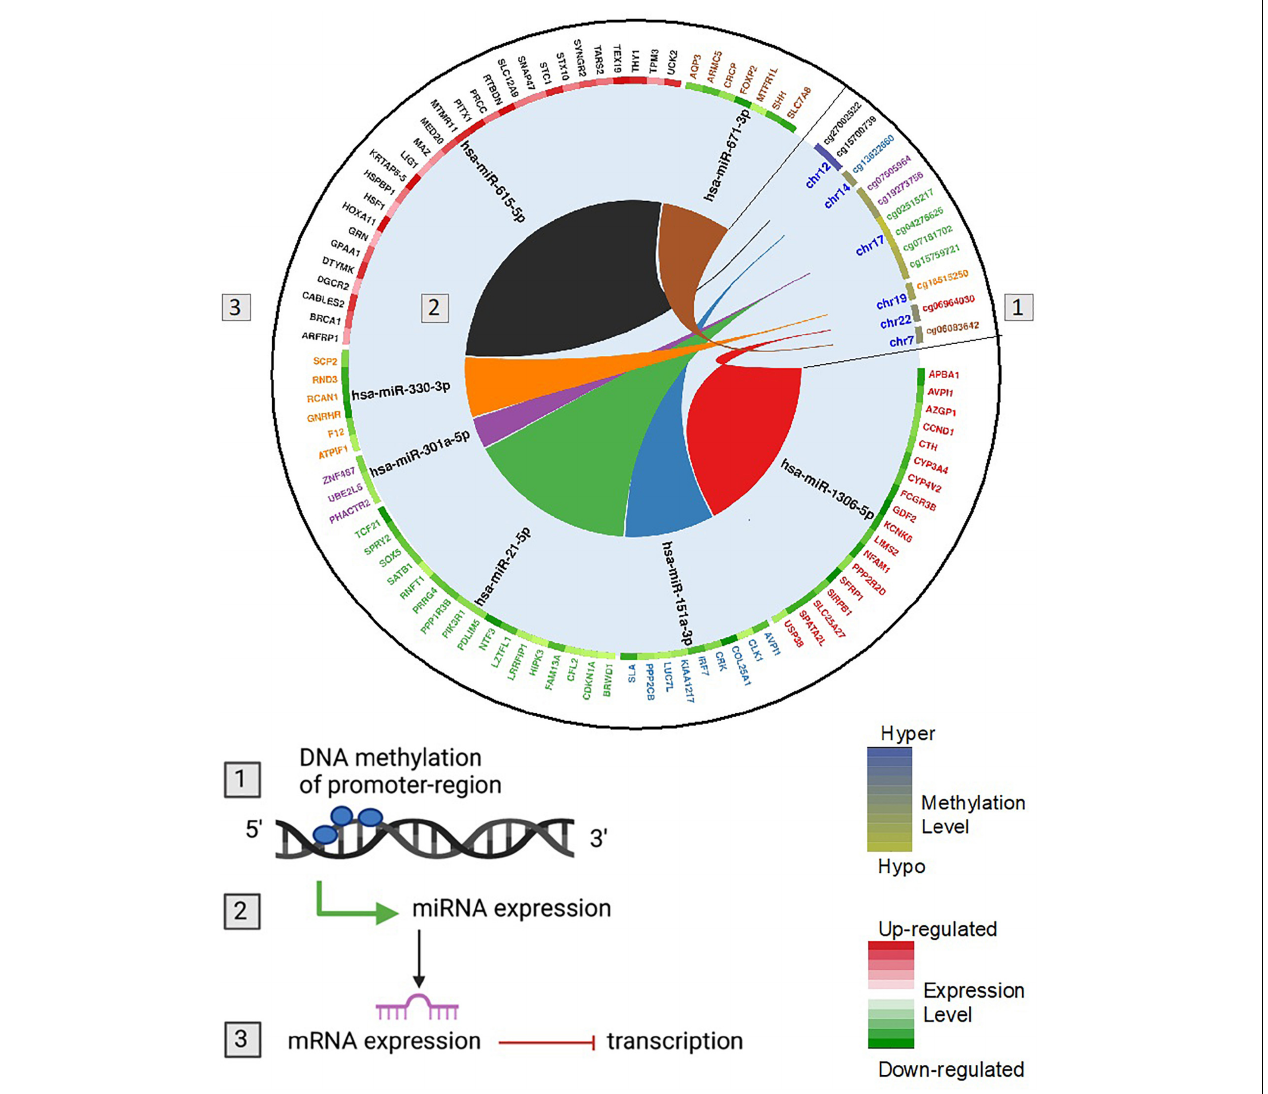
FIGURE 7 | Circos plot showing DNA methylation regulation of miRNA and genes potentially targeted by miRNAs at the post-transcriptional level. The colors follow the integration across (1) DNA methylation → (2) miRNA expression → (3) target mRNA expression. Hypermethylated (blue) and hypomethylated (yellow) status of CpG sites is depicted as a heatmap for differentially methylated CpG though to regulate miRNA expression. Up (red) and down (green) regulation of gene expression is depicted as a heatmap for each gene that is an identified miRNA target. The miRNAs have reciprocal regulation compared to the target mRNA genes. For example, cg06964030 is significantly hypomethylated in HCC and located in the promoter region of hsa-miR-1306-5p. Hsa-miR-1306-5b is significantly upregulated in HCC and from using the miRNA Target Filter function in Ingenuity Pathway Analysis (IPA) is known to regulate genes APBA1, AVPI1, AZGP1, CCND1, CTH, CYP3A4, CYP4V2, FCGR3B, GDF2, KCNK6, LIMS2, NFAM1, PPP2R2D, SFRP1, SIRPB1, SLC25A27, SPATA2L, USP38. All of these genes are significantly downregulated in HCC tumors relative to adjacent normal